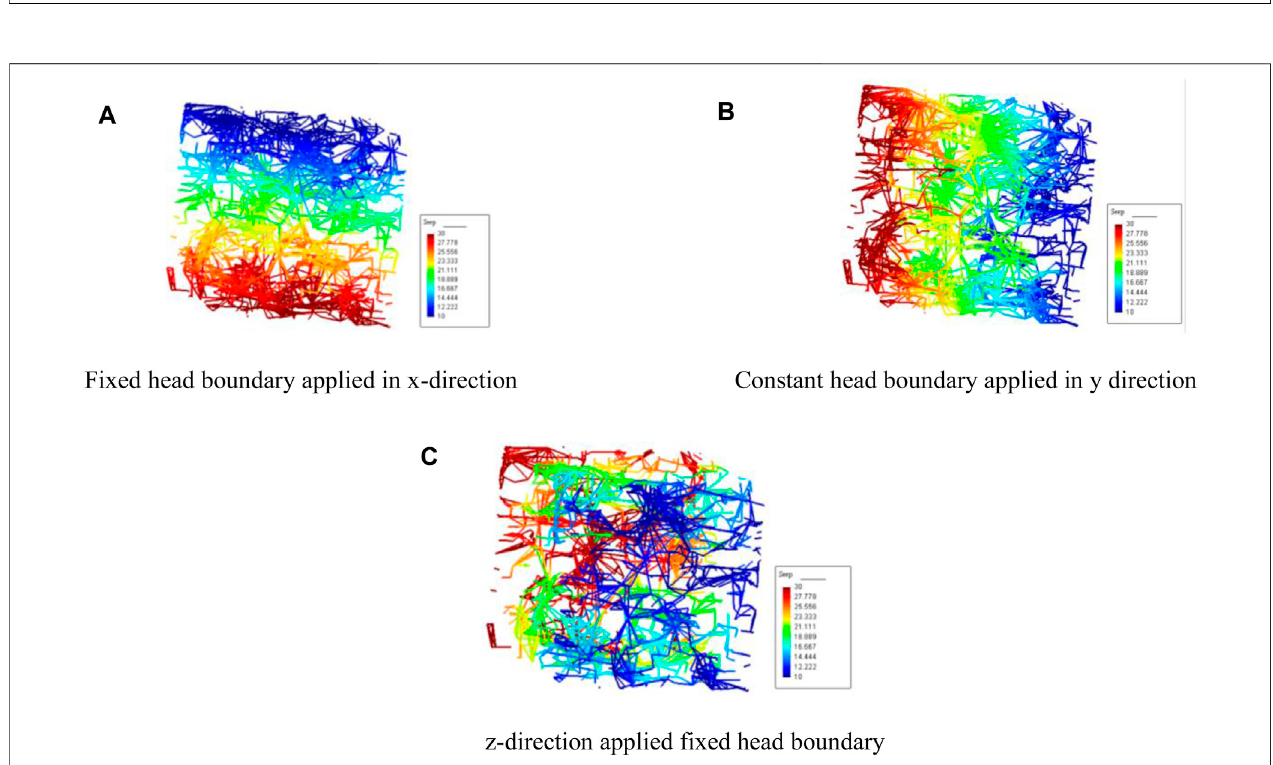
FIGURE6| Threegroupsofsimulatedheaddistribution: (A) fi xedheadboundaryappliedinthex-direction, (B) constantheadboundaryapplied iny-direction, and (C) z-direction applied fi xed head boundary.